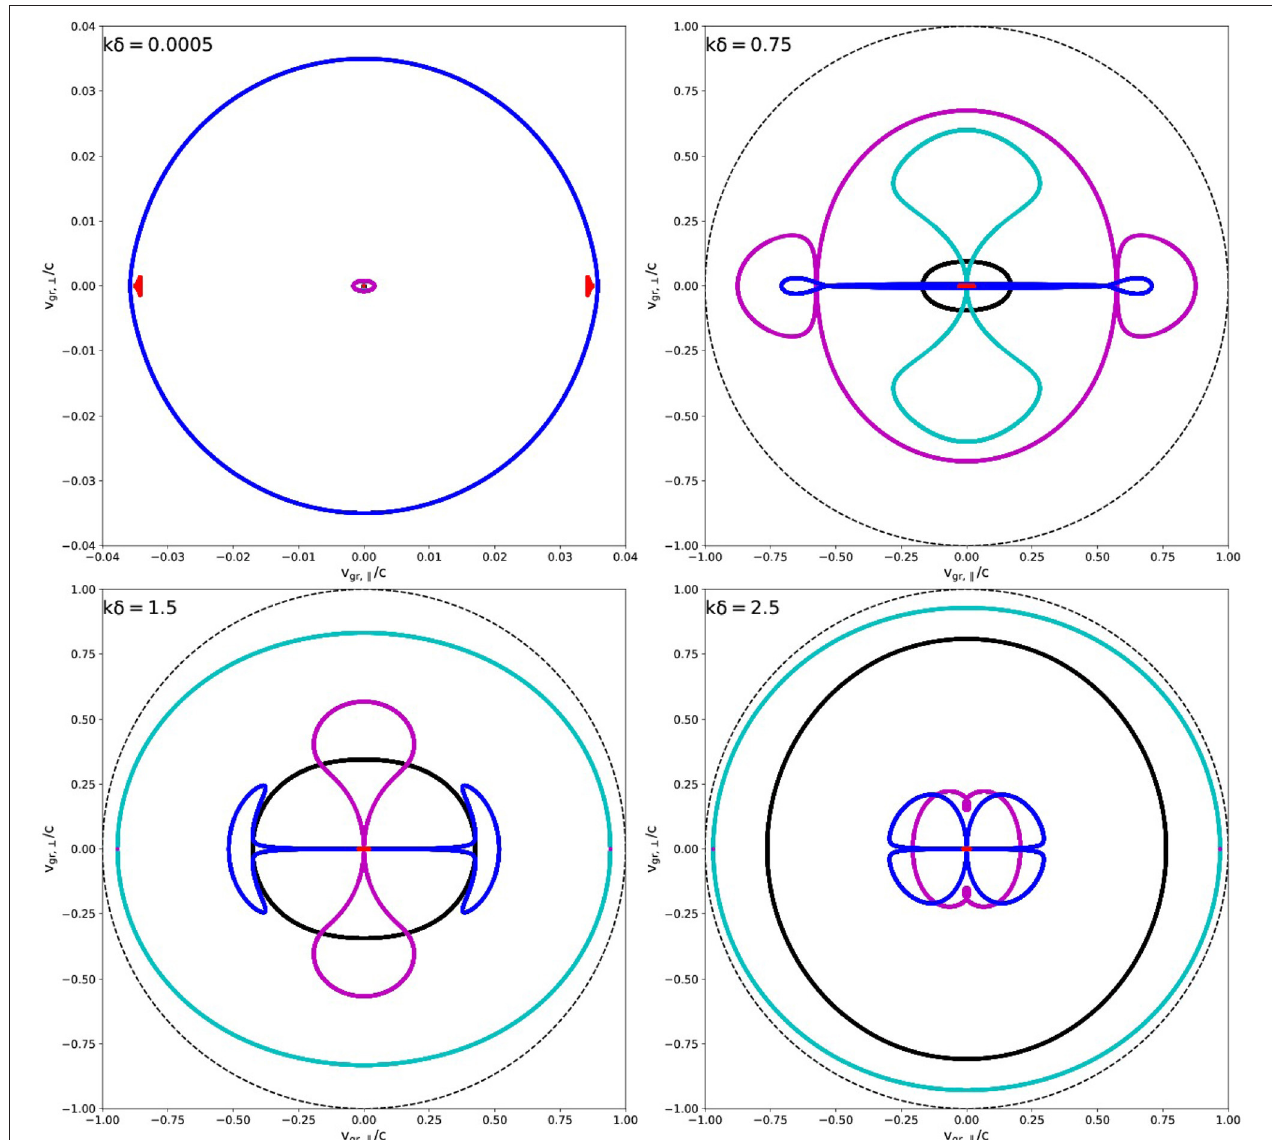
FIGURE 6 | Selected 5-mode group diagrams at four different values of k circle, notice the varying scale used in the top left plot. This is for a hydrogen plasma with E electromagnetic modes are black ( ω X ) and cyan ( ω O ), followed by purple ( ω M or Middle), blue ( ω F or Fast) and red ( ω A or Alfvén)